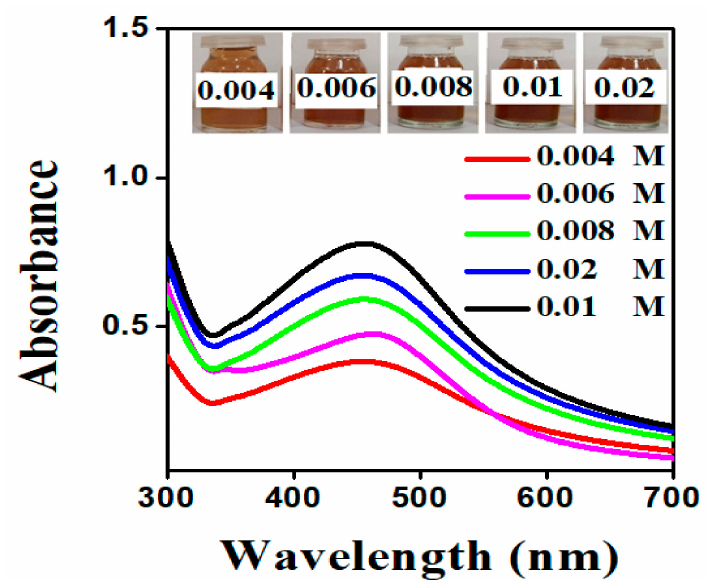
Figure 2. UV-visible spectrum of synthesized AgNPs from S. procumbens aqueous extract at various concentrations of AgNO 3